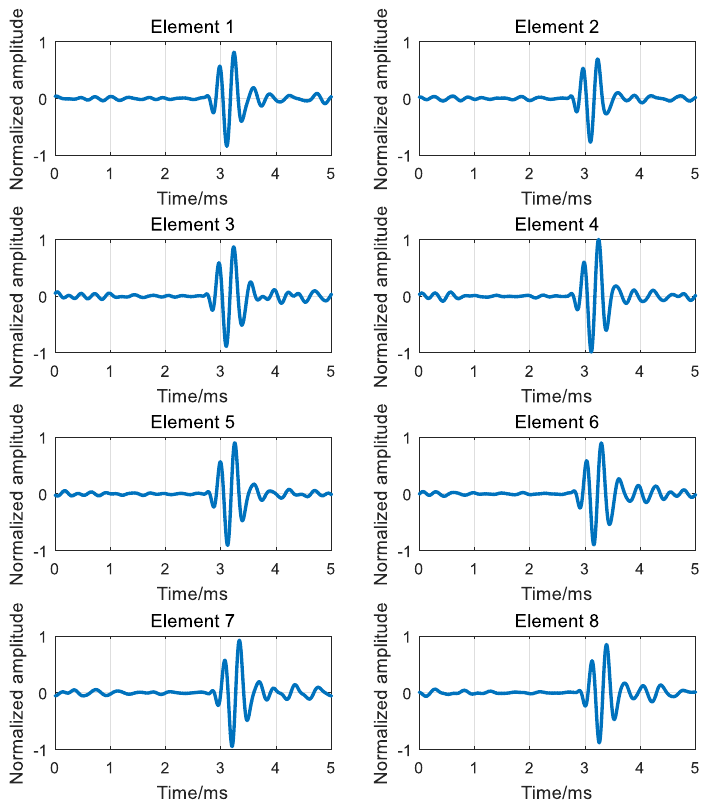
Figure 11. The first received signals of element 1 – 8.